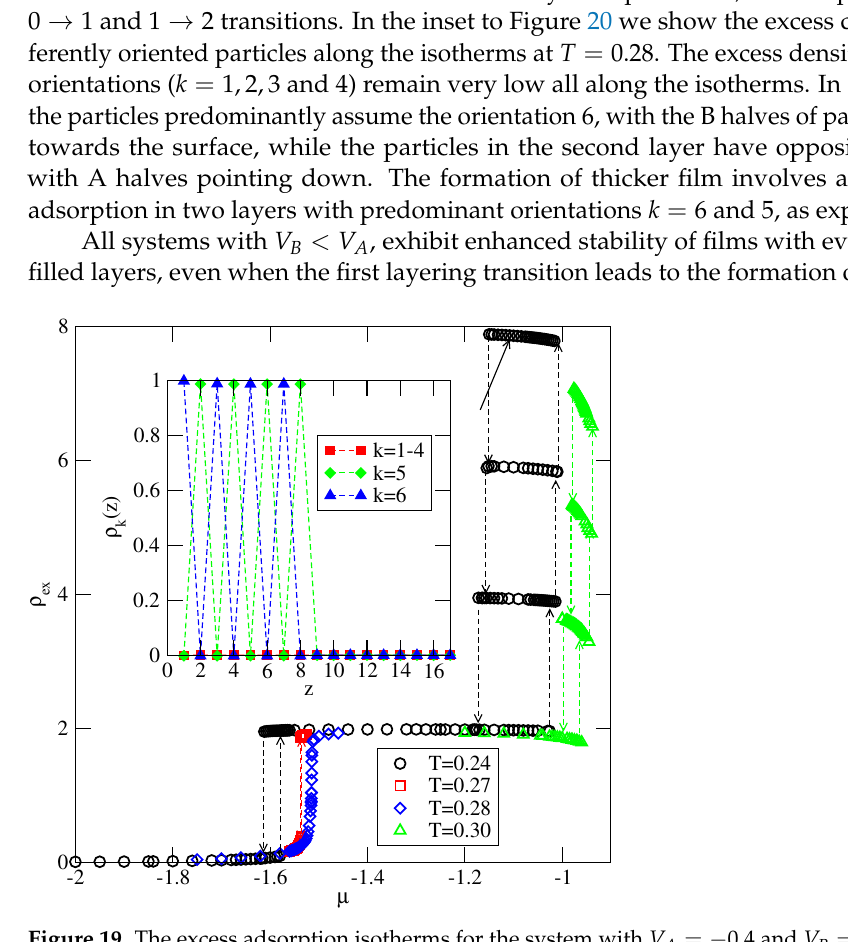
Figure 19. The excess adsorption isotherms for the system with V A = − 0.4 and V B = − 1.0. The inset shows the profiles of differently oriented particles, recorded at T = 0.24 and µ − 1.13 in the film with eight occupied